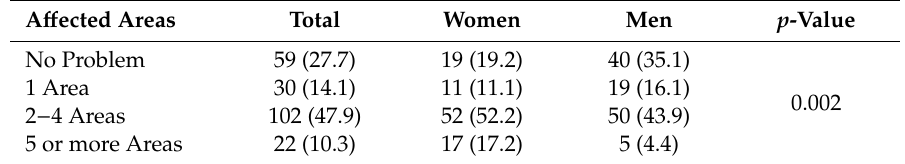
Table 4. Number of a ff ected areas in the last seven days and comparison by gender ( n = 213). A ff ected Areas